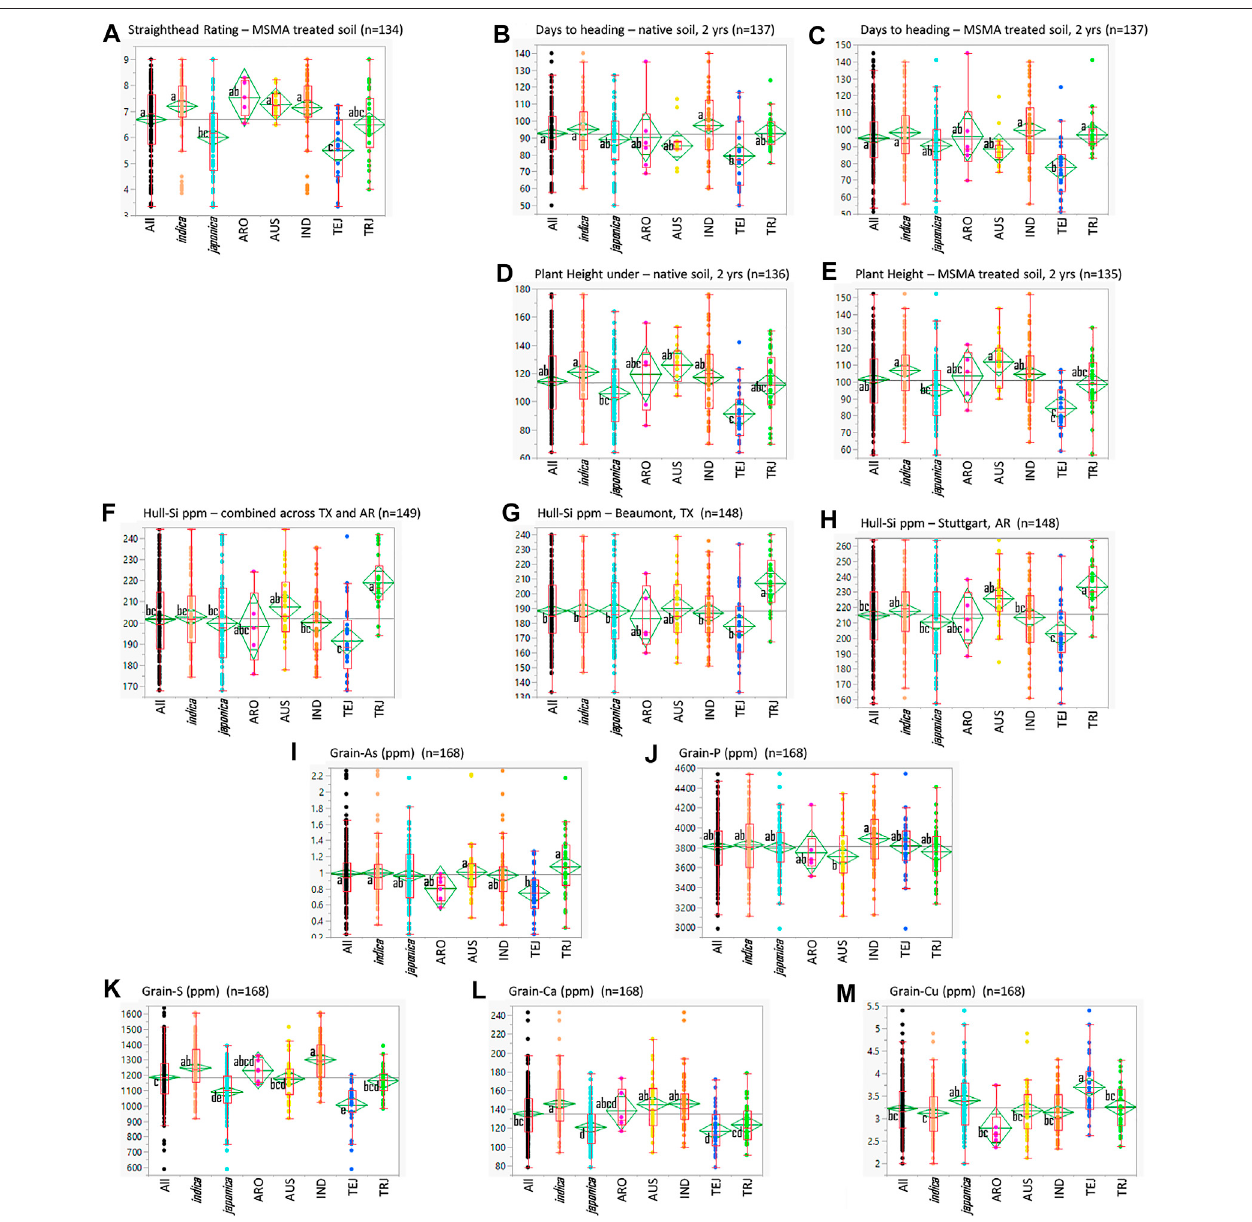
FIGURE 1 | Quantile plots comparing the various traits in the entire USDA Rice Minicore (All) and the O. sativa subspecies (indica and japonica) and their subpopulations, aromatic (ARO), aus (AUS), indica (IND), temperate japonica (TEJ), and tropical japonica (TRJ). Lower and upper sides of boxes indicate the 25th and 75th percentiles, respectively; horizontal lines in boxes are medians, vertical lines indicate the 5th and 95th percentiles; and dots indicate full ranges of observed data. Difference among the small letters beside subpopulation means indicates differences among the means at α = 0.05.